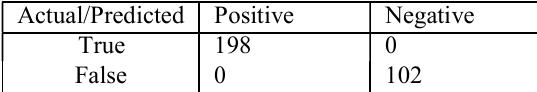
Table 3. CONFUSION MATRIX OF RF